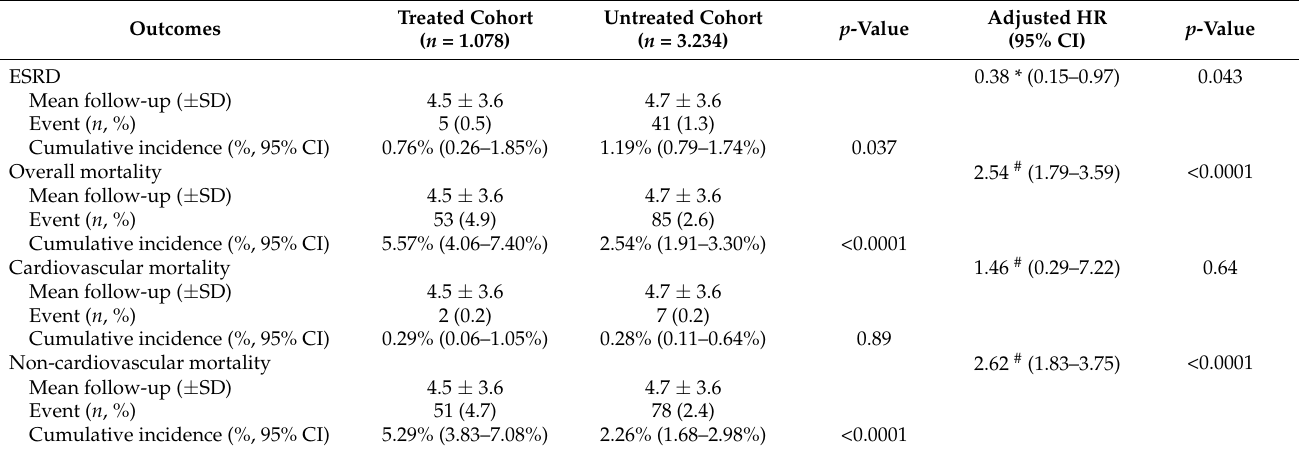
Table 2. Study outcomes and incidences in the three study cohorts.